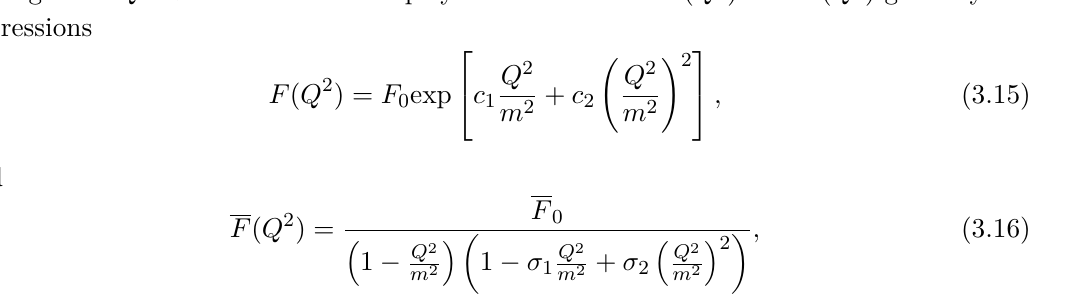
Figure 4 . The strong coupling G = G (1 GeV 2 ) as a function of the Borel parameters M 2 at s 0 = 20 . 5 GeV 2 and s 0